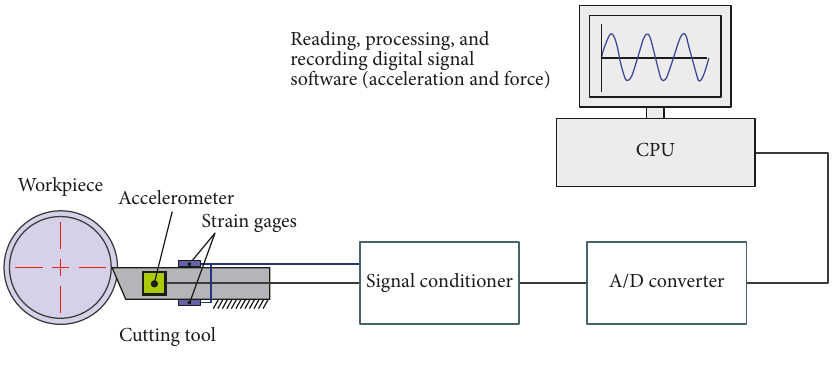
Figure 2: Measurement system.